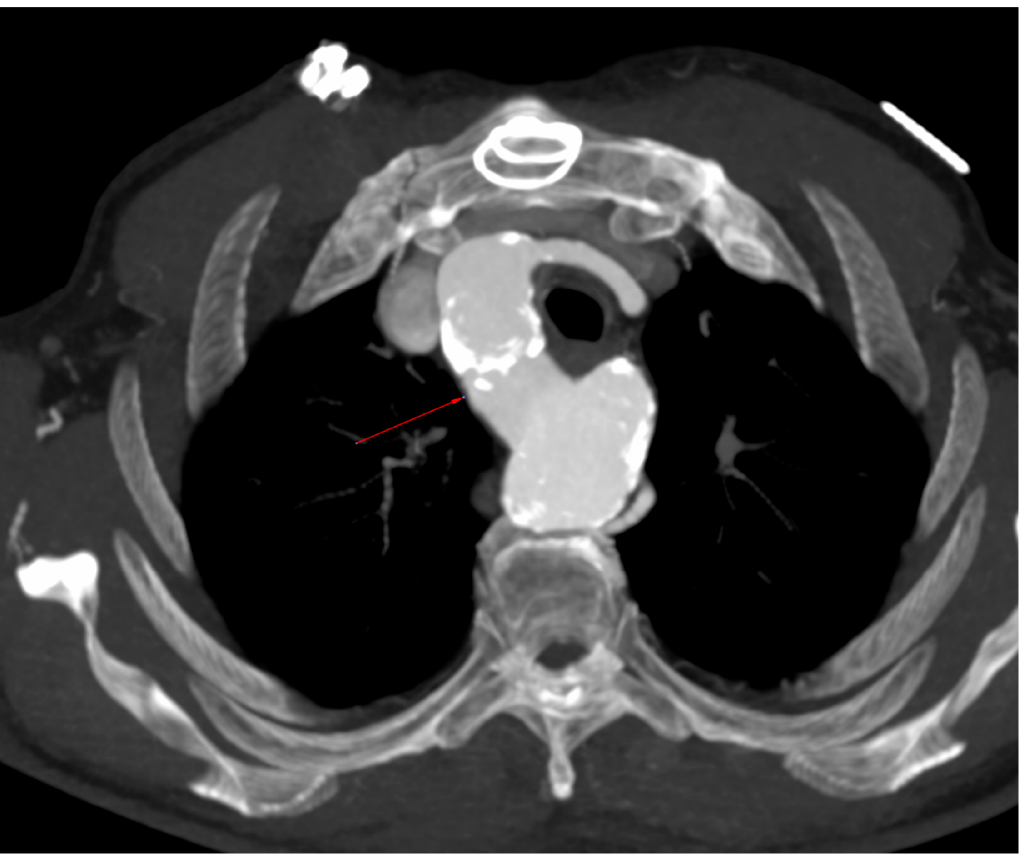
Figure 3. Right aortic arch.